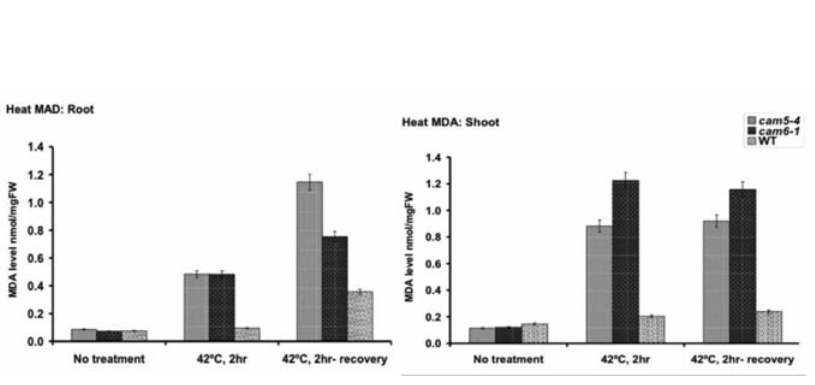
Figure 4. Oxidative damage by high temperature exposure in cam mutants of A. thaliana . The malonaldehyde (MDA) level was determined in root and shoot tissues by the thio- barbiturate reactive substances (TBARS) assay describe in materials and methods. Two set of seedlings were treated at 42ºC for 2 hours. One set was used immediately for meas- urement of MDA level, while the other set was allowed to recover for 2 days under con- tinuous light at 25°C before determination of MDA level (nmol/mg FW). Error bars rep- resent the standard deviation over three replicate plates with 50 seedlings on each